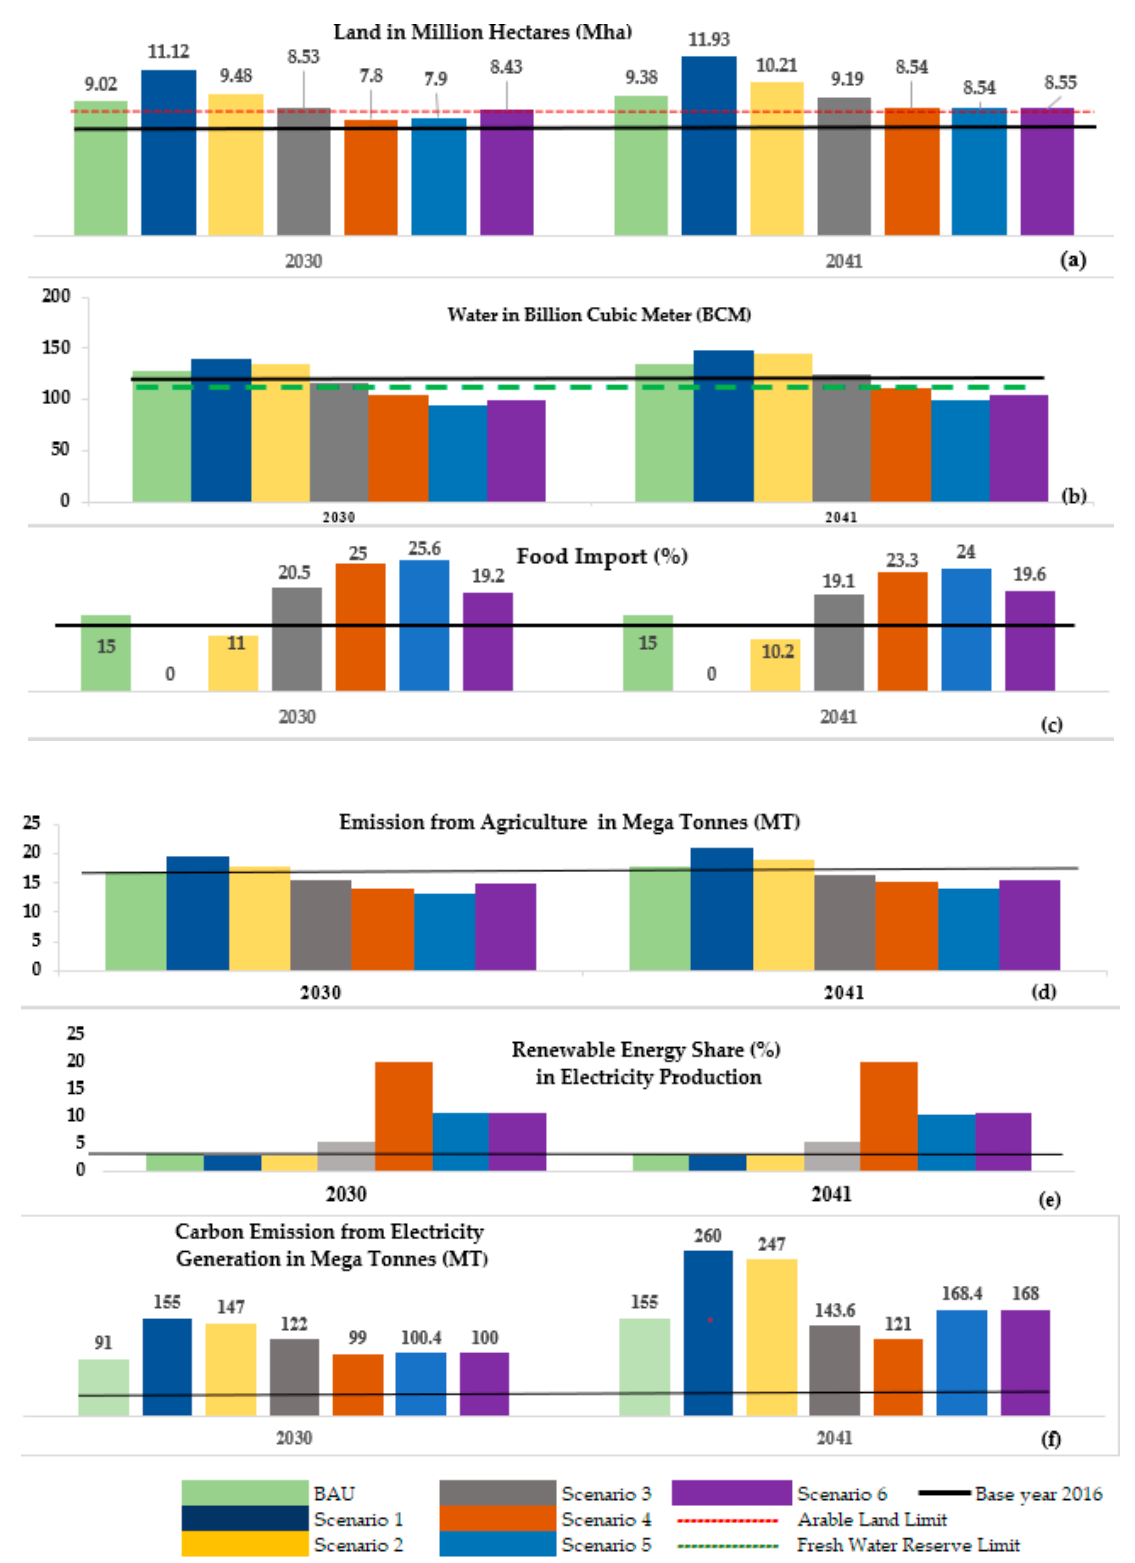
Figure 5. Comparative evaluation of scenarios. ( a ) Land demand, ( b ) freshwater demand, and ( c ) food import. ( d ) Emission from crop production, ( e ) renewable energy share in electricity production, and ( f ) carbon emission for listed scenarios.